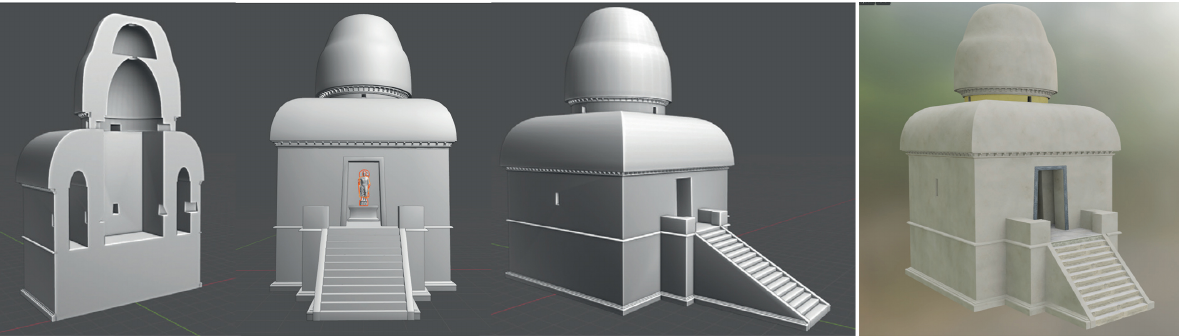
Figure 13 . Reconstructive 3D model of